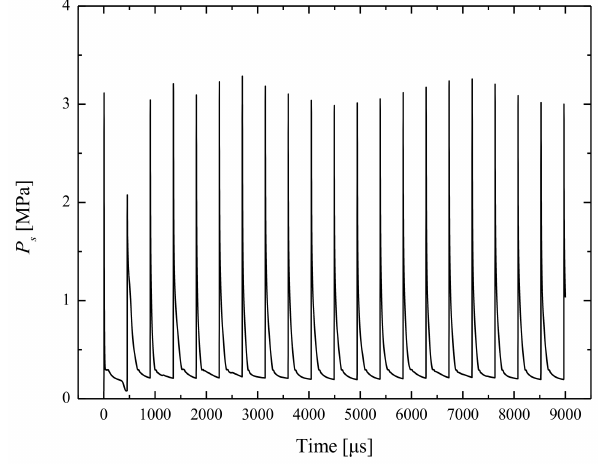
Figure 3. Variation in static pressure over time at the monitoring point of (215,